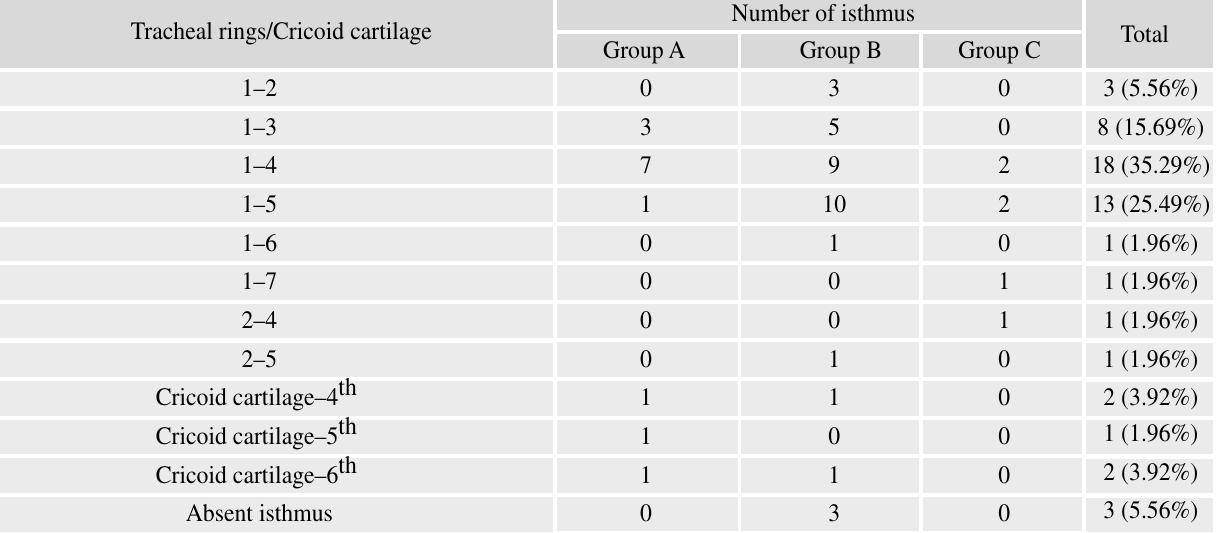
Table I: Posterior relation of isthmus with tracheal rings and cricoids cartilage Tracheal rings/Cricoid